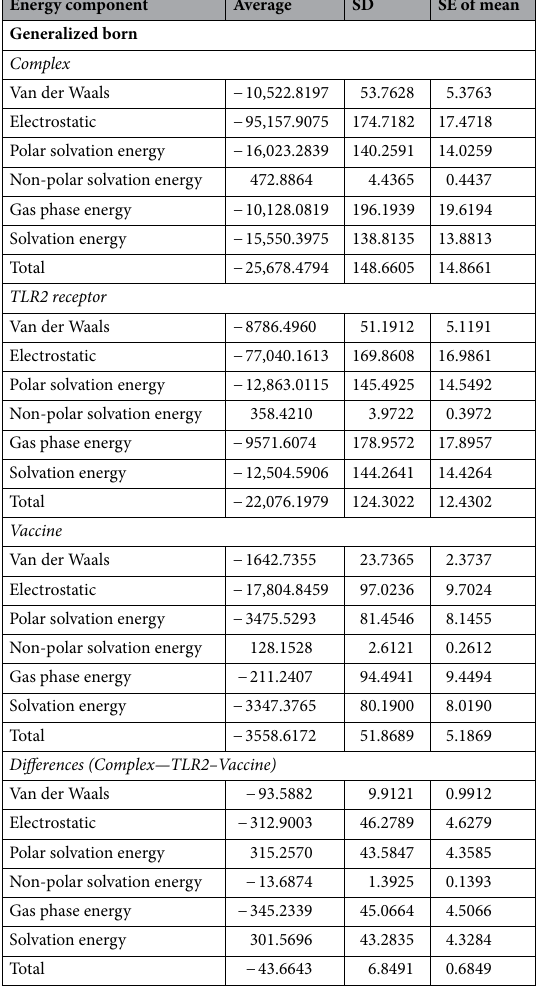
Table 2. MMGBSA based binding free energies of the complex, TLR2, vaccine and net delta energy in kcal/